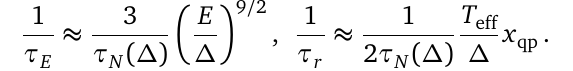
is defined in z